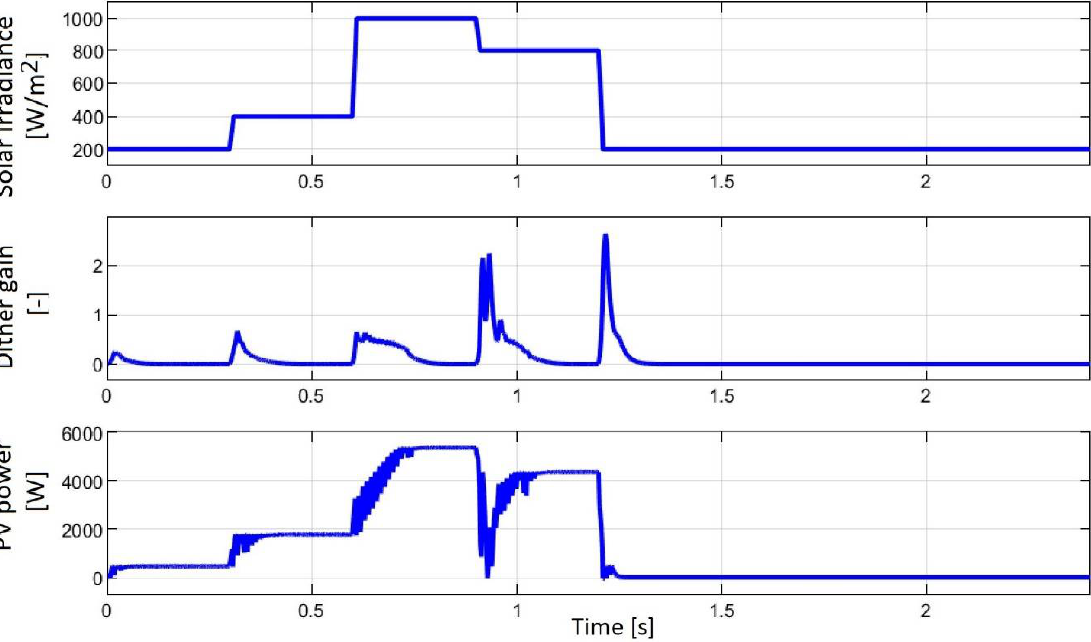
Figure 7. PV/ESS system under variable solar irradiance profile with very high slopes.